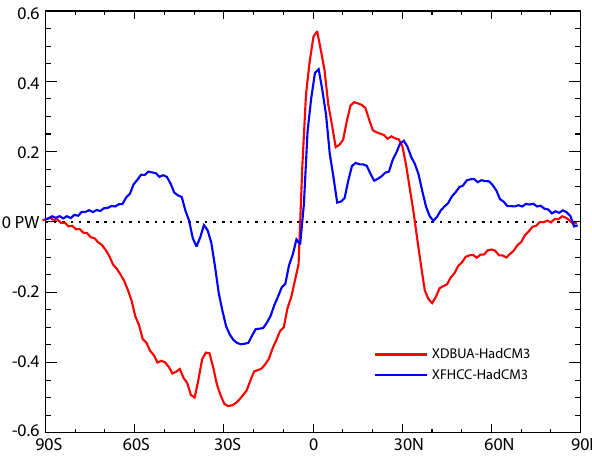
Fig. 6. Difference in magnitude of the annual average at- mospheric energy transport between FAMOUS and HadCM3. Black: XDBUA-HadCM3; red: